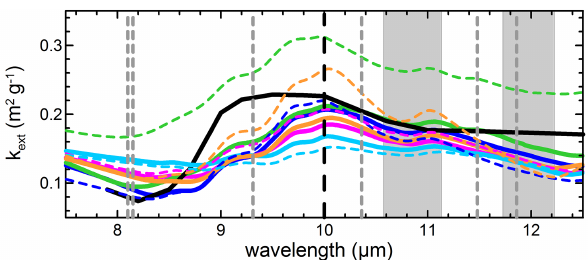
Figure 9. Mass extinction efficiency ( k ext , m 2 g − 1 ) calculated for the five dust cases within the 7.5–12.5µm spectral range. Accord- ing to Fig. 8, continuous and dashed lines correspond to k ext calcu- lations performed by considering, respectively, the same size distri- bution for all dust cases (continuous lines) and the own size distribu- tion corresponding to each sample (dashed lines). Vertical lines and the two shaded areas refer to the following different satellite remote sensing channels: (grey dashed lines) six AIRS channels for dust retrieval in the thermal infrared (8.10, 8.15, 9.31, 10.36, 11.48, and 11.86µm); (black dashed line) IASI channel for dust optical depth retrieval at 10µm; and (grey shaded areas) the two MODIS broad- band channels (10.78–11.28 and 11.77–12.27µm) used for sea sur- face temperature (SST)